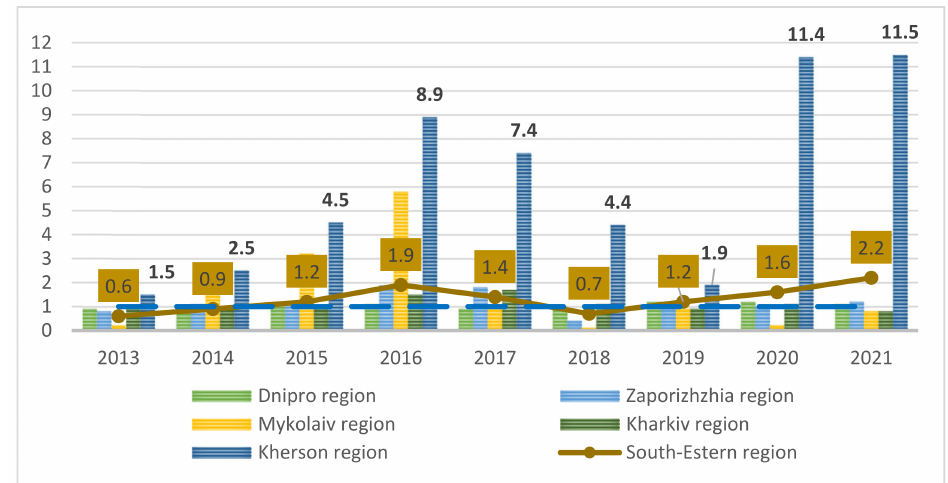
Figure 6. Productivity index of capital investments in electricity, gas, steam, and air conditioning supplies in the south-eastern region of Ukraine and some regions, 2013–2021 (constructed by the authors according to the data [40,41]).